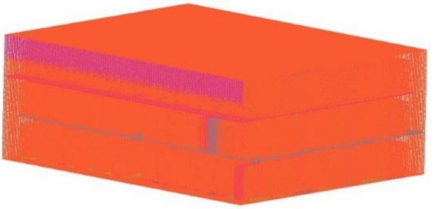
Figure 2. Schematic diagram of the battery pack grid.